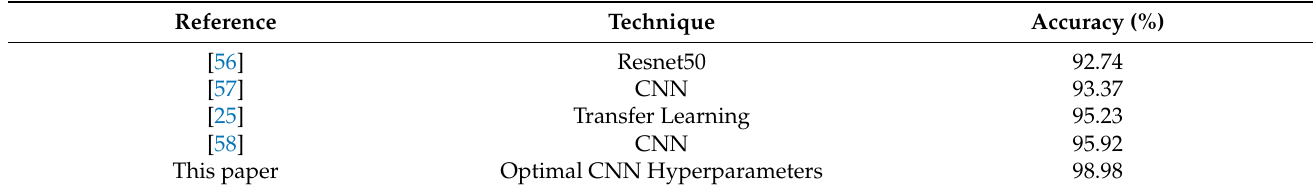
Table 11. X-ray data set performance comparison.